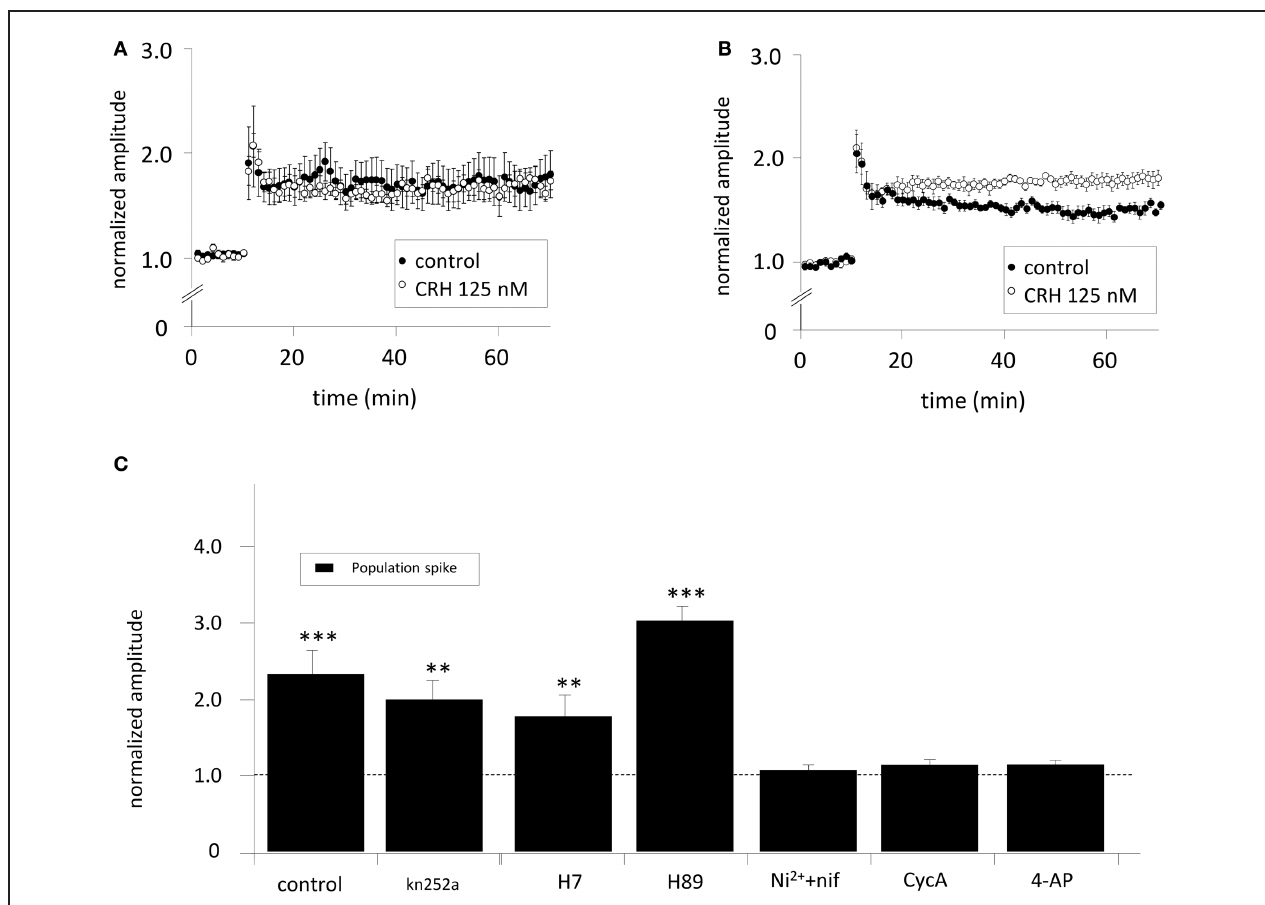
FIGURE 3 | (A) The effect of CRH on CA1-LTP depends on the site of electrical stimulation. When SC-stim-fEPSPs were recorded, CRH did not change LTP induced by HFS (control: 173 . 3 ± 19 . 8 %; n = 5, in the presence of CRH: 171 . 3 ± 8 . 2%; n = 5, p > 0 . 05). However, when HFS was delivered to the CA3 stratum pyramidale, (B) CRH increased the potentiation of CA3-stim-fEPSPs from 154 . 8 ± 5 . 0% ( n = 6) under control conditions to 180 . 6 ± 8 . 1% ( n = 6; p < 0 . 05 for control vs. CRH). (C) The effect of CRH on the population spike amplitude is dependent on phosphatase 2B (PP-2B), voltage-gated potassium channels (K V ) and T- and L-type calcium channels. PS were recorded from the CA1 pyramidal